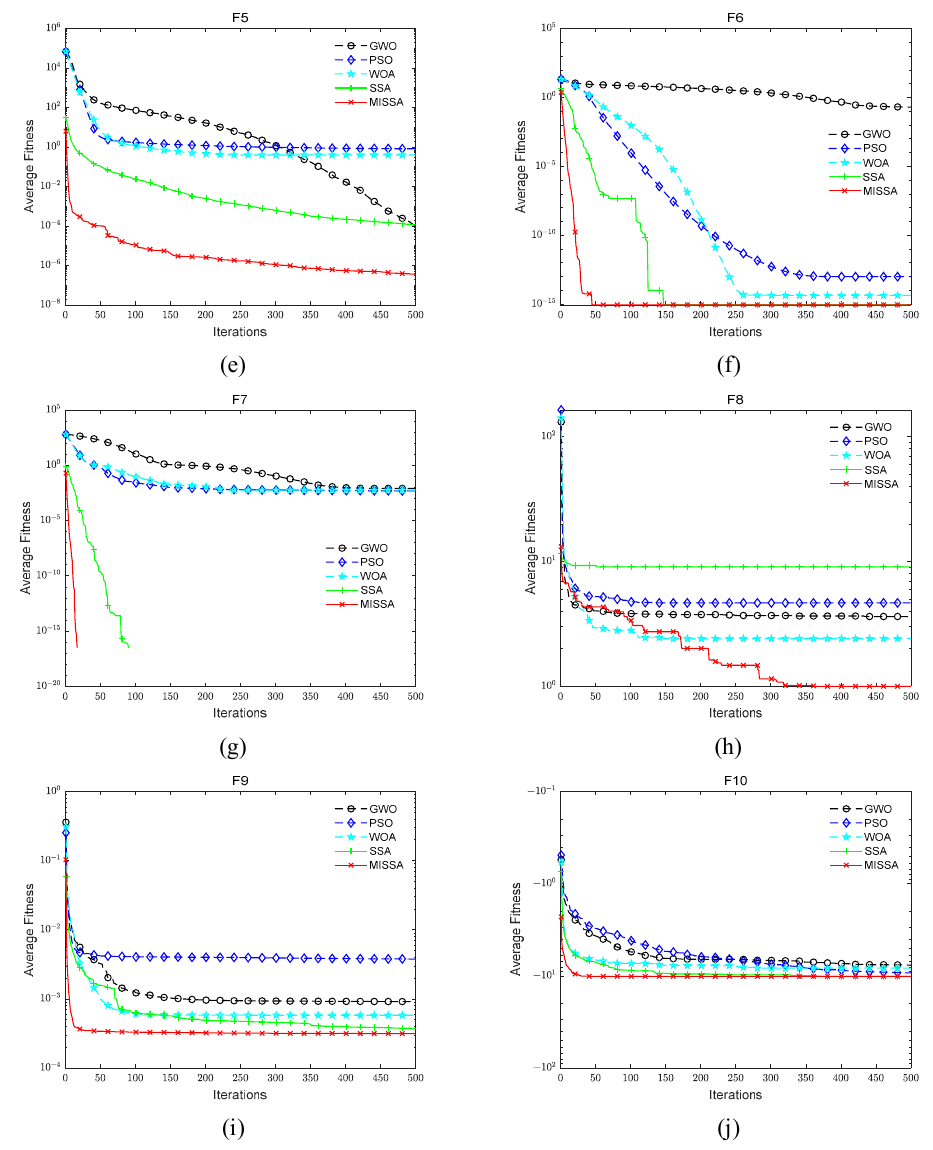
Figure 7. Convergent curve of five algorithms on ten benchmarks functions: ( a ) function F1; ( b ) function F2; ( c ) function F3; ( d ) function F4; ( e ) function F5; ( f ) function F6; ( g ) function F7; ( h ) function F8; ( i ) function F9; ( j ) function F10.